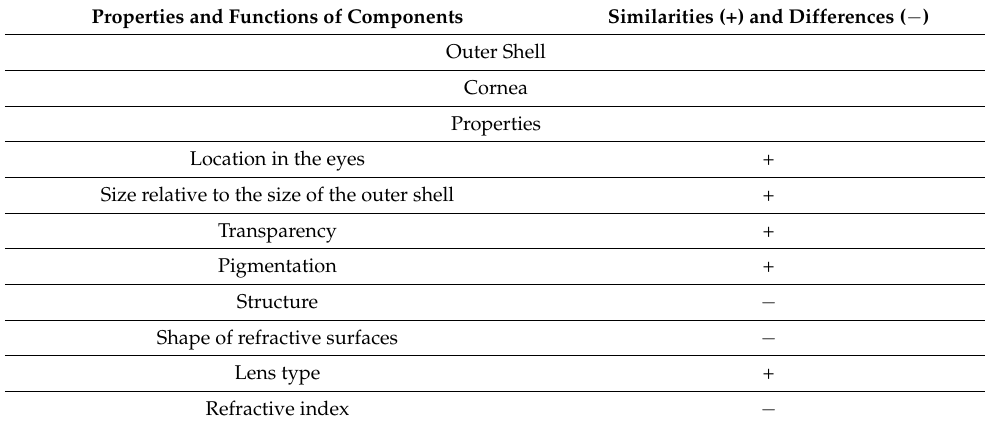
Table 1. Similarities and differences between the components of the principle and secondary camera- like eyes of jumping spiders and